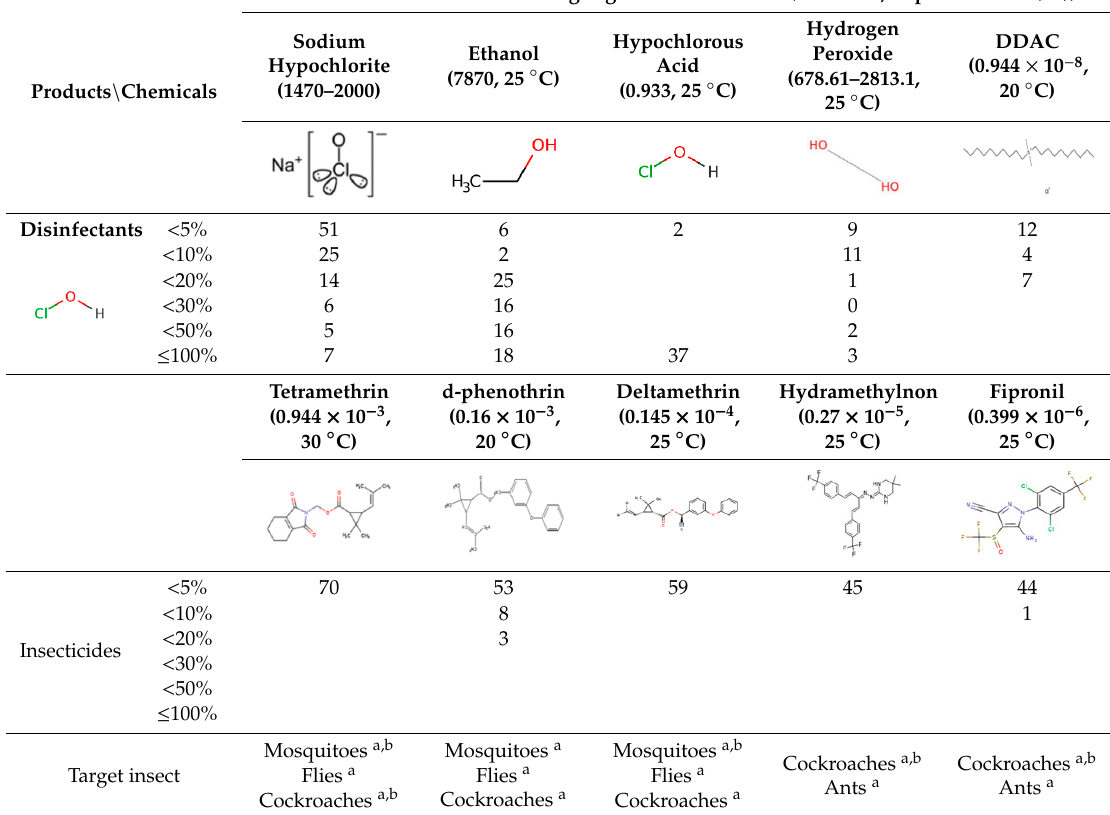
Table 6. Mixing ratio of major chemicals used in products as ingredients. Products \ Chemicals